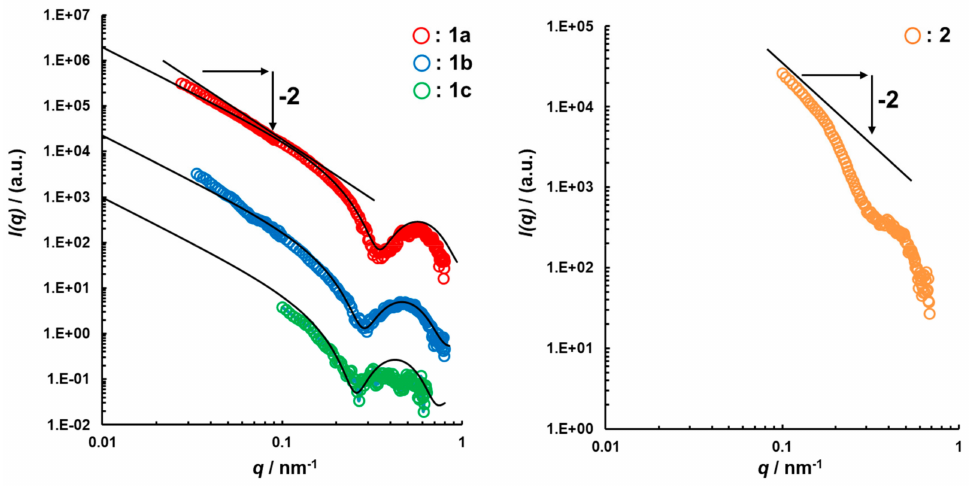
Figure 4. Small angle X-ray scattering (SAXS) profile and structural parameters of polymersomes ( A ) 1a – c and ( B ) 2